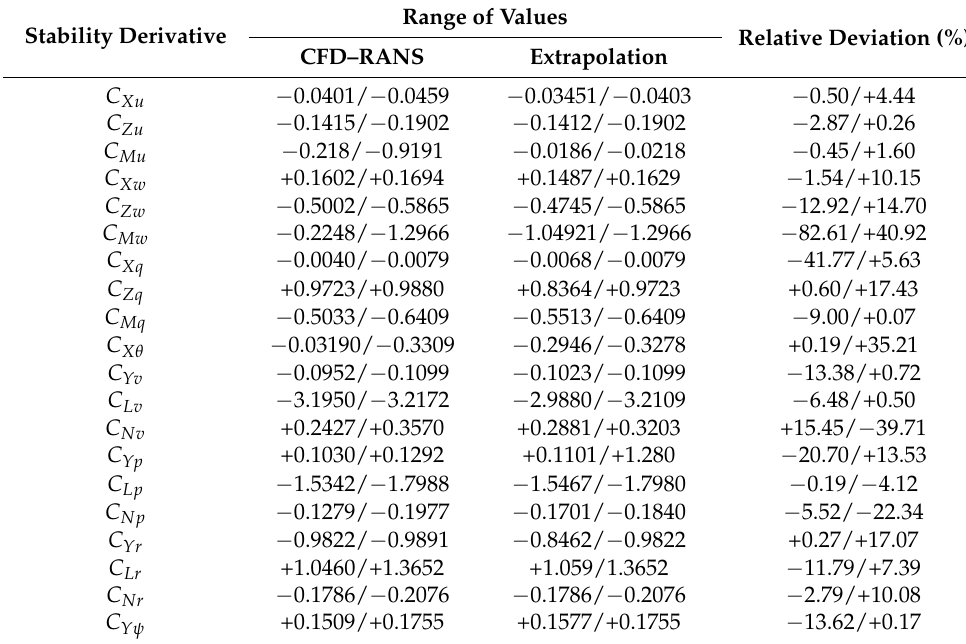
Table 35. Comparison of extrapolation with CFD–RANS